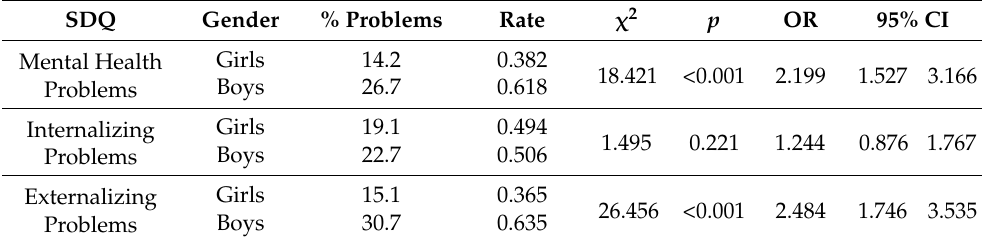
Table 1. Odds ratio (OR) depending on the different dependent variables studied ( Mental Health Problems, Internalizing Problems, Externalizing Problems ) and